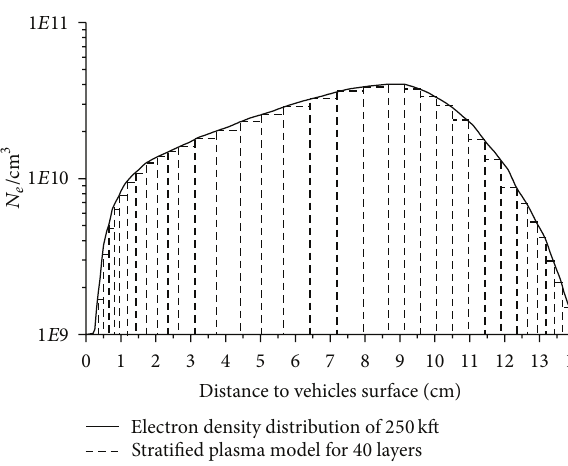
Figure 2: Inhomogeneous plasma sheath stratified